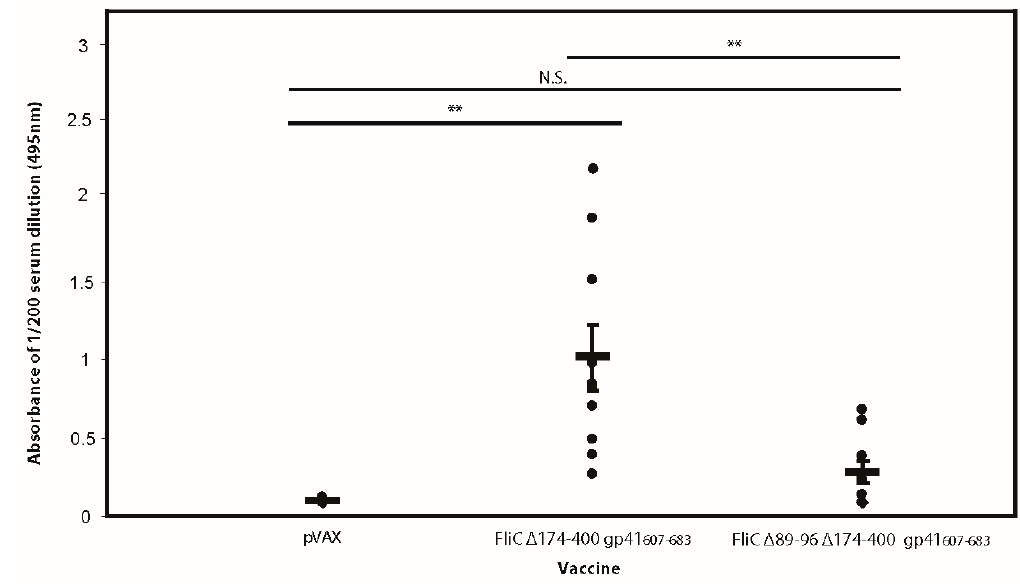
Figure 7. Deletion of FliC residues 89–96 results in a reduced adjuvant effect on HIV-1 gp41 607–683 immunogenicity. Female BALB/c mice (10 mice per experimental arm) were injected intramuscularly with either pVAX (empty vector) or DNA vaccines FliC Δ 174–400 gp41 607–683 or FliC Δ 89–96 Δ 174–400 gp41 607–683 (50 μ L in each hind leg at a concentration of 1 μ g/ μ L). Two weeks following the 4th vaccination, mouse serum (1:200 dilution) was analyzed for a gp41 607–683 specific IgG response. Each point represents the mean absorbance value obtained from individual mouse serum (each with two replicates per mouse). Horizontal bars represent average values per vaccine group and error bars represent standard error of the mean. Significance was determined using an unpaired t -test with ** indicating a p value < 0.01.